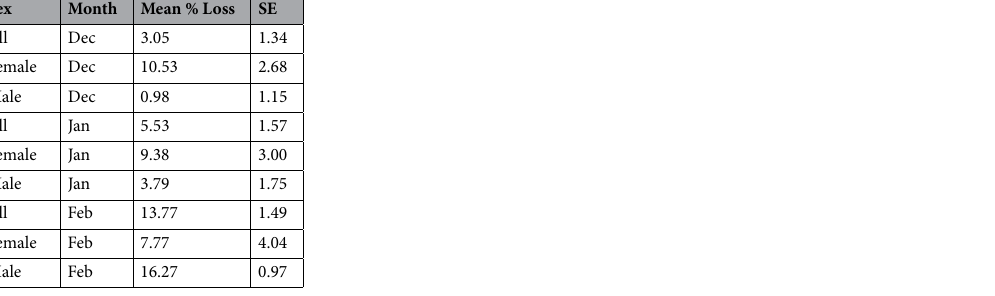
Table 2. Mean monthly percentage body mass loss of male and female hedgehogs over winter in Qatar.